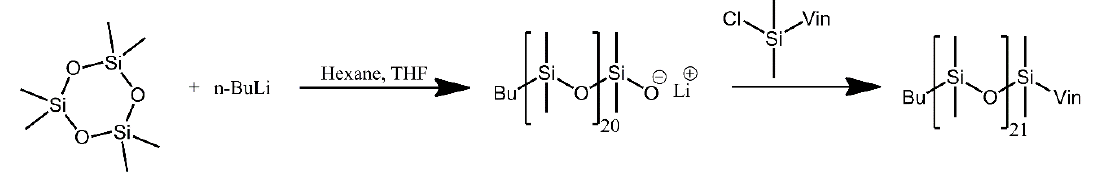
Figure 14. Synthesis of the PDMS arm. Vin stands for a vinyl group. Based on Ref. [36].